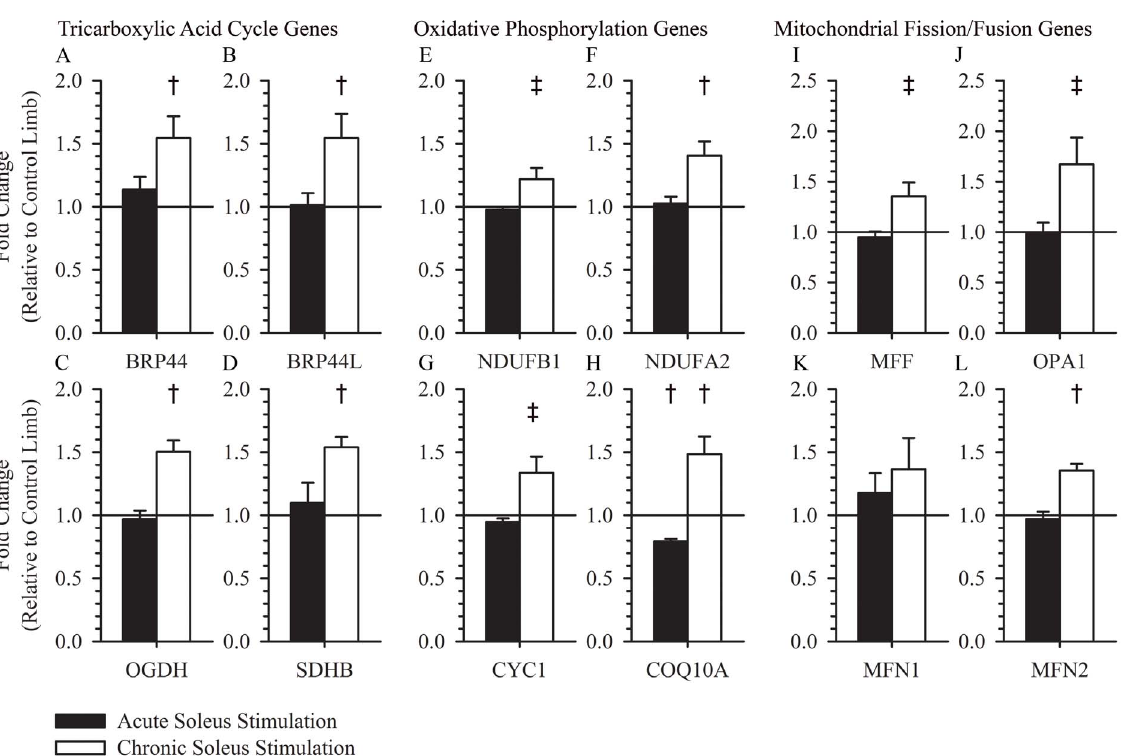
Fig. 5. Expression of tricarboxylic acid cycle, oxidative phosphorylation, and mitochondrial fission/fusion genes following acute or chronic stimulation. BRP44 (1.55 ¡ 0.17, p 5 0.034), BRP44L (1.55 ¡ 0.19, p 5 0.036), OGDH (1.50 ¡ 0.092, p 5 0.007), and SDHB (1.54 ¡ 0.081, p 5 0.004) were increased after . 1 year of muscle training, but were unchanged 3 hours after a single dose of muscle stimulation (1.14 ¡ 0.099, p 5 0.25, 1.02 ¡ 0.093, p 5 0.97, 0.97 ¡ 0.067, p 5 0.58, 1.10 ¡ 0.16, p 5 0.74; respectively) (A, B, C, and D). NDUFB1 (1.22 ¡ 0.088, p 5 0.067), NDUFA2 (1.40 ¡ 0.11, p 5 0.022), and CYC1 (1.34 ¡ 0.13, p 5 0.066) were increased after . 1 year of muscle training, but were unchanged 3 hours after a single dose of muscle stimulation (0.98 ¡ 0.02, p 5 0.28, 1.03 ¡ 0.05, p 5 0.72, 0.95 ¡ 0.03, p 5 0.10; respectively) (E, F, and G). COQ10A was increased after . 1 year of muscle training (1.49 ¡ 0.14, p 5 0.024), but was decreased 3 hours after a single dose of muscle stimulation (0.79 ¡ 0.021, p , 0.001) (H). MFF (1.35 ¡ 0.14, p 5 0.062), OPA (1.67 ¡ 0.27, p 5 0.074), and MFN2 (1.35 ¡ 0.053, p 5 0.004) were increased after . 1 year of muscle training, but were unchanged 3 hours after a single dose of muscle stimulation (0.95 ¡ 0.31, p 5 0.31, 1.00 ¡ 0.78, p 5 0.77, 0.97 ¡ 0.54, p 5 0.54); respectively) (I, J, and L). MFN1 was unchanged after . 1 year of muscle training (1.36 ¡ 0.25, p 5 0.22) and 3 hours after a single dose of muscle stimulation (1.18 ¡ 0.16, p 5 0.42) (K). { indicates a p-value , 0.05 for a within group paired t-test. { indicates a p-value , 0.10 for a within group paired t-test.